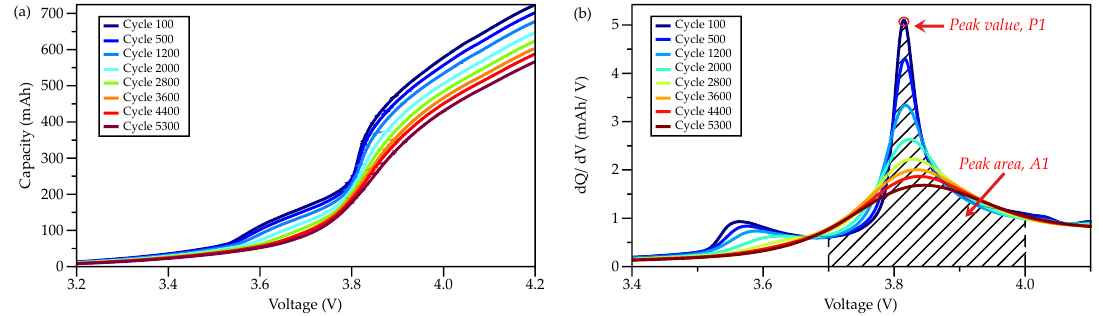
Figure 6. ( a ) Charged capacity curves of cell 1; ( b ) Smoothed IC curves of cell 1.